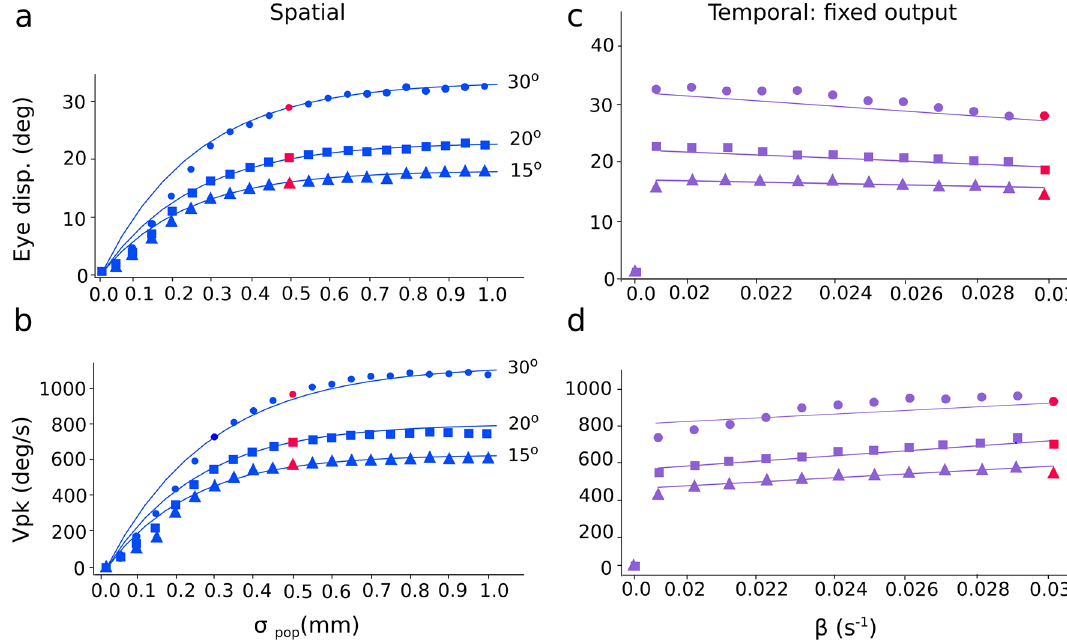
Figure 8. ( a ) Eye-displacement amplitude, and ( b ) peak eye velocity, as a function of the input current’s population size for stimulation at sites corresponding to T = 15, 20 and 30 deg. Beyond the default input population size of σ pop = 0.5 mm (red symbols), the eye displacement amplitude and peak eye velocity are nearly independent of stimulation strength, while below 0.5 mm they both systematically decrease with decreasing input size. ( c ) Eye-displacement amplitude, and ( d ) peak eye velocity, as a function of the input current’s temporal parameter at sites corresponding to T = 15, 20 and 30 deg. The input currents generate fixed number of spikes at SC layer. Whereas the eye displacement remained invariant, peak eye velocity increased with β: the shorter the input duration (large β), the higher the